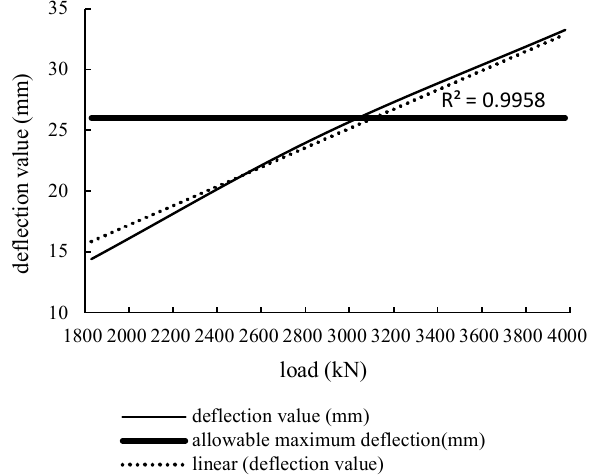
Figure 9. The relationship curve between the maximum deflection and the load value in mid-span.